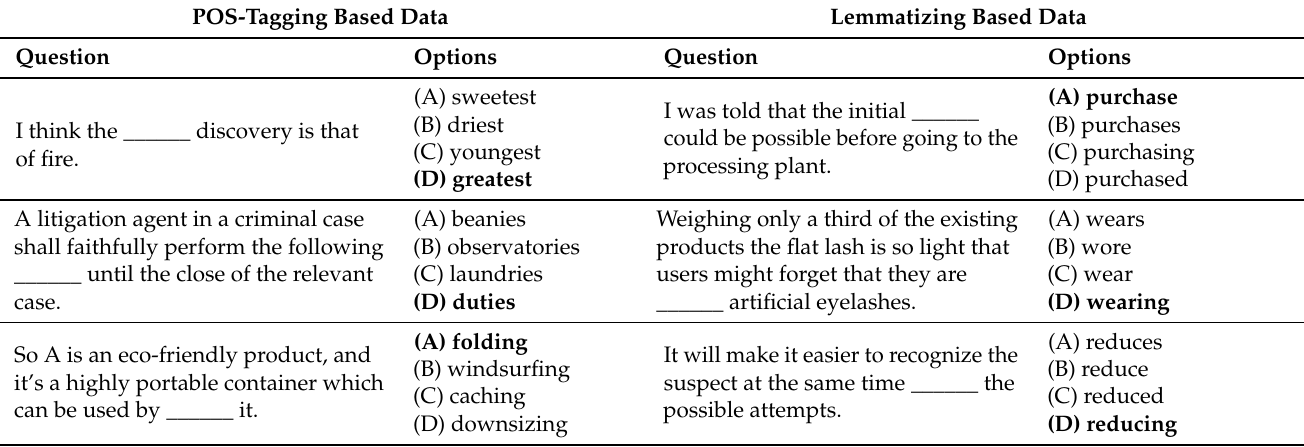
Table 3. Examples of POS-tagging Based Data and Lemmatizing Based